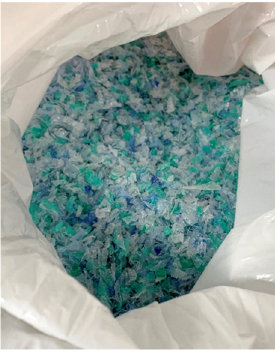
Figure 1. Plastic raw material used for the chemical and mecchanical process. Two mortar mixtures (M2_25 and M3_50) containing DPET additive produced from glycolysis chemical degradation of plastic bo tt les were tested and compared with a target mortar (M1_0). DPET aggregate was incorporated in the target mortars, replacing di ff er- ent sand weight ratios, i.e., 25% and 50%. Portland cement type CEM I-52.5R and fi ne sand